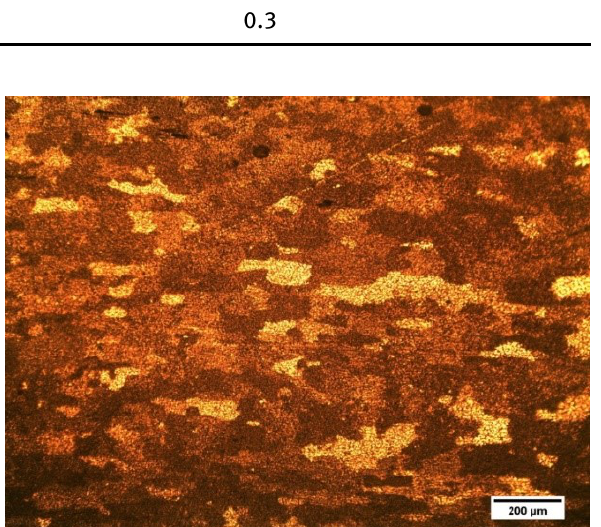
Figure 3: Microstructure of substrate metal AA